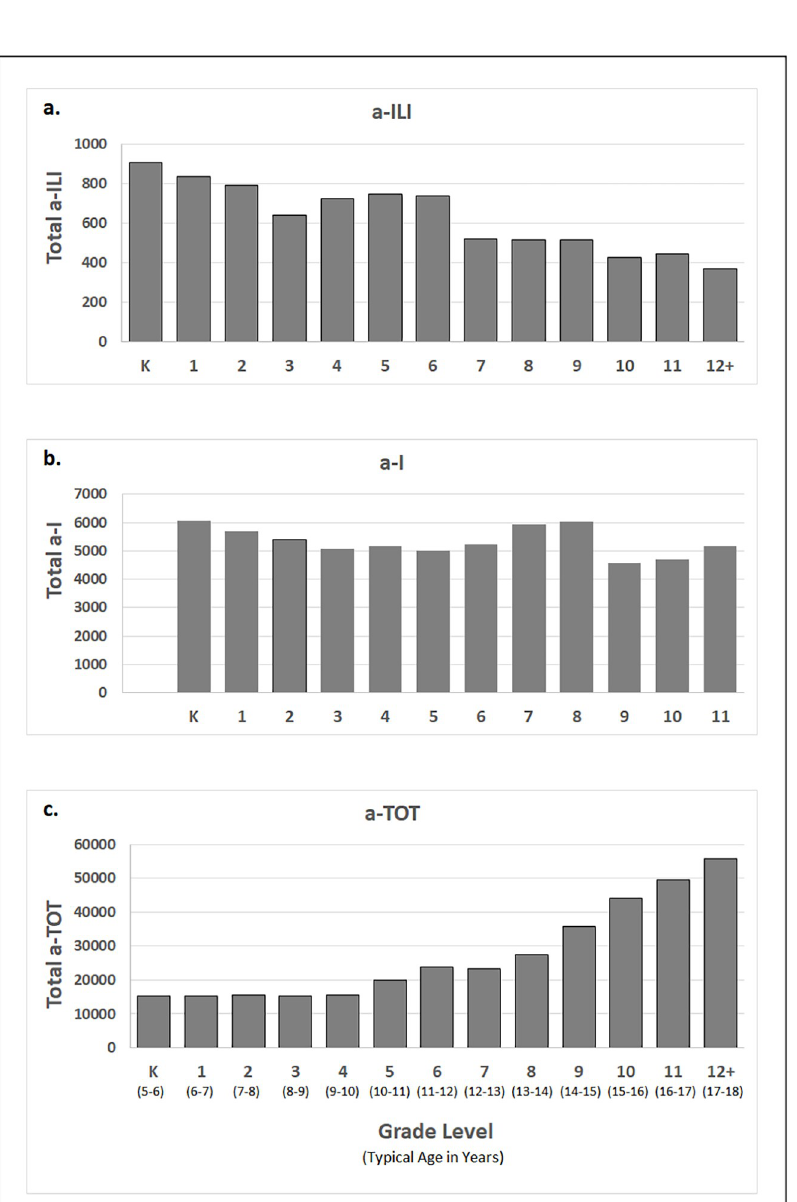
Fig 3. Total absentee counts, by grade level, across entire study for a-ILI, a-I and a-TOT. Defined types of absenteeism: a-TOT = absent for any reason; a-I = absent due to illness; a-ILI = absent due to influenza-like illness.